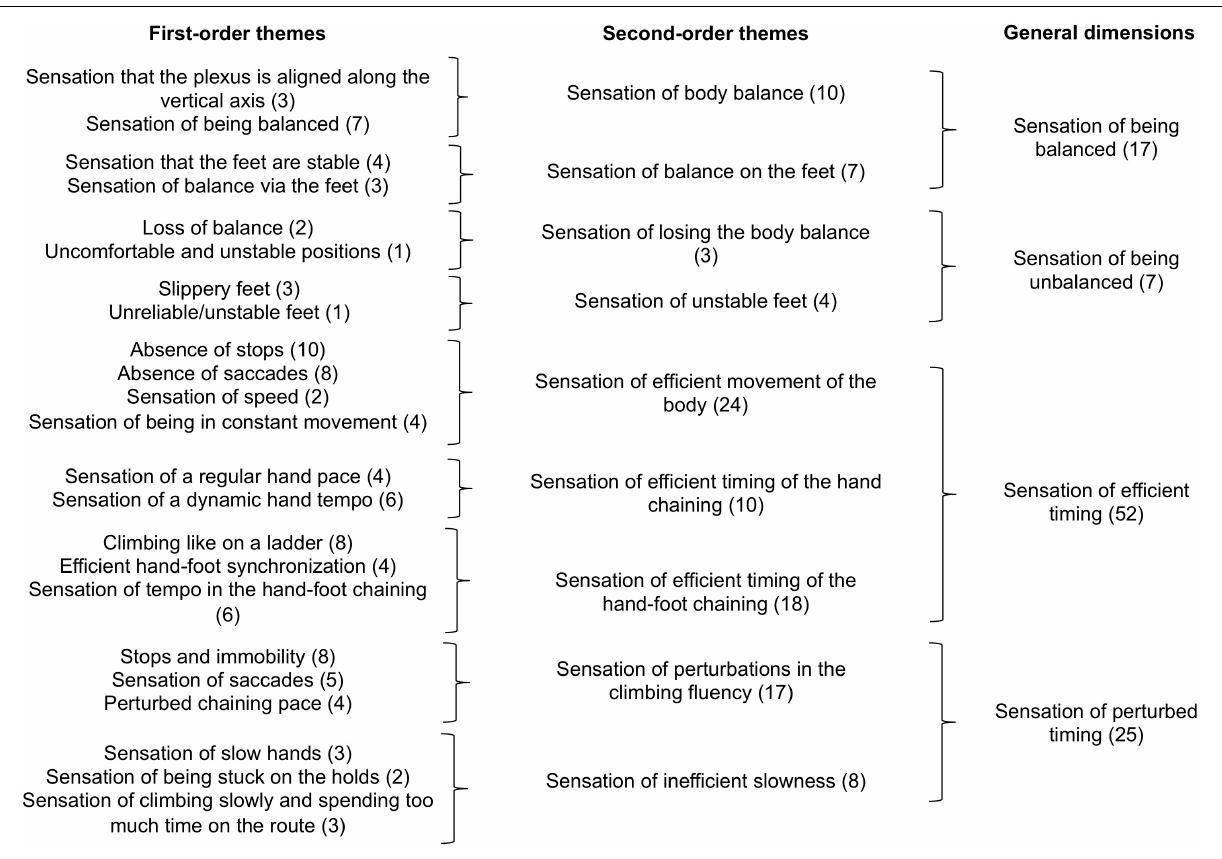
FIGURE 3 | Thematic analysis of the climber’s perceptions. The first column presents the first-order themes. The second column presents the second-order themes (i.e., merging of the first-order themes). The third column presents the general dimensions (i.e., merging of the second-order themes). The numbers in the parentheses associated with each theme refer to the number of occurrences identified from the